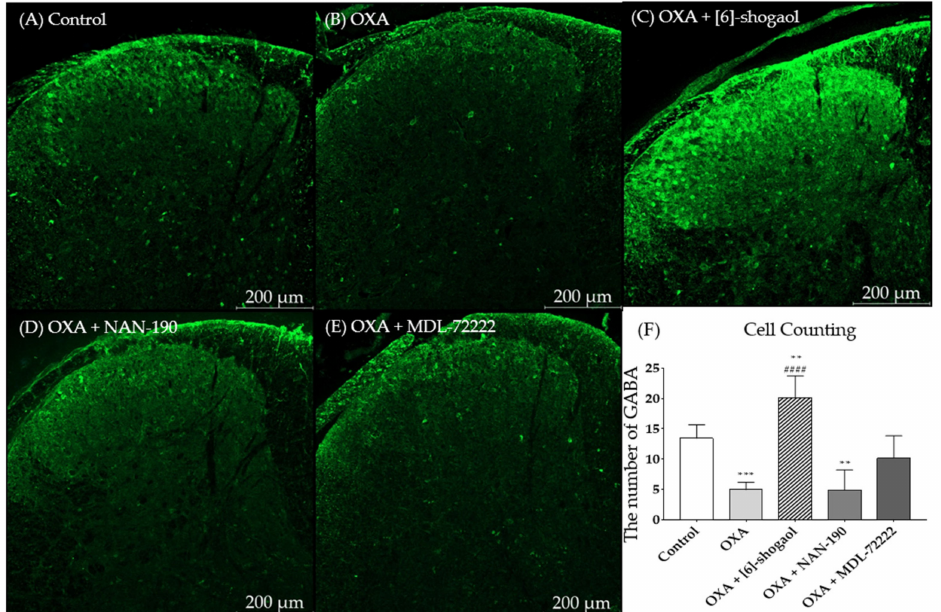
Figure 5. Change of GABA concentration after [6]-shogaol and 5-HT receptor antagonists admin- istration in superficial laminae of dorsal horn of lumbar 4 -5 spinal cord segments. The lumbar 4–5 segment of the spinal cord of control, ( A ) oxaliplatin (OXA), ( B ) [6]-shogaol, ( C ) OXA + NAN-190, ( D ) OXA + MDL-72222, and ( E ) treated mice were stained with GABA antibodies. After immunohis- tochemistry GABA (green) was quantified ( F ). All groups, except control group, received oxaliplatin injection four days prior to the experiments. Control group received 5% glucose. Data are presented by mean ± SEM. Control: n = 5, OXA: n = 6, [6]-shogaol: n = 6, NAN-190: n = 5, MDL-72222: n = 5. ** p < 0.01, *** p < 0.001 vs. Control and #### p < 0.0001 vs. OXA with one-way ANOVA followed by Tukey’s multiple comparisons test.